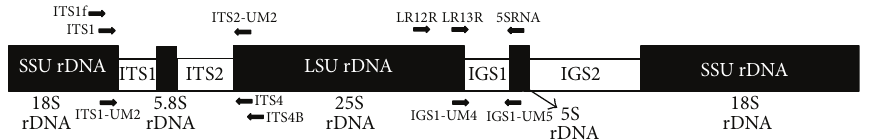
Figure 1: Primer binding sites used to amplify IGS1 and ITS regions. The arrowheads show the 3 󸀠 end of each primer. LSU rDNA represents the large subunit ribosomal DNA and LSU rDNA represents the small subunit ribosomal DNA. Table 3: The reference sequences used in this study, downloaded from NCBI GenBank. IGS1 ITS1&2